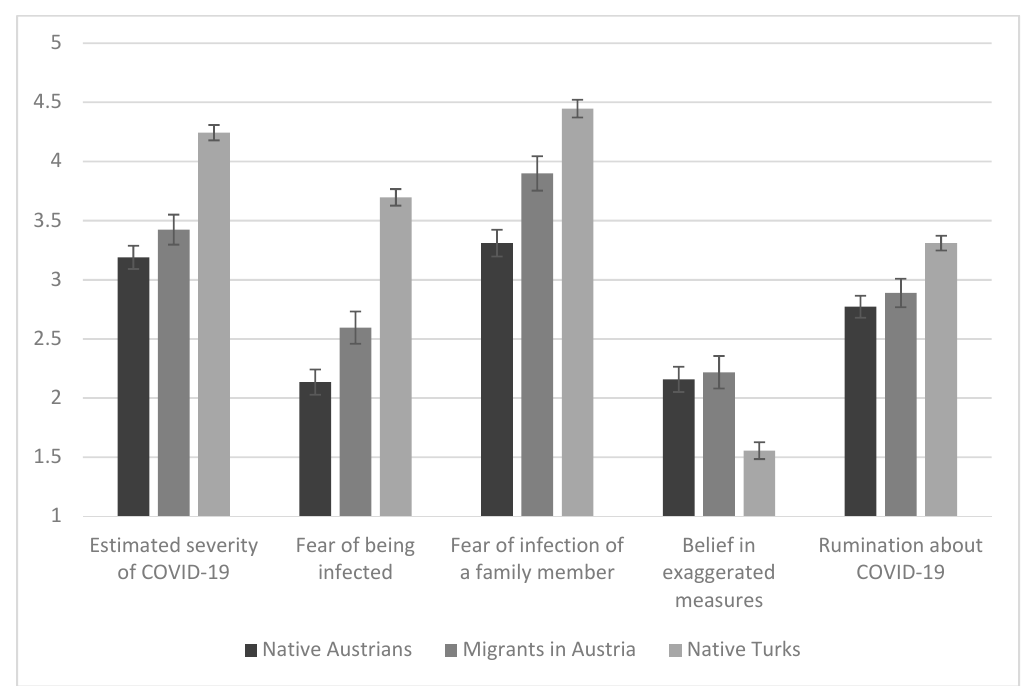
Figure 1. COVID-19 related cognitions with M and SEM in the different groups. The means are depicted after controlling for the effect of age and gender. The y-axis indicates the possible range of the ratings of the items.